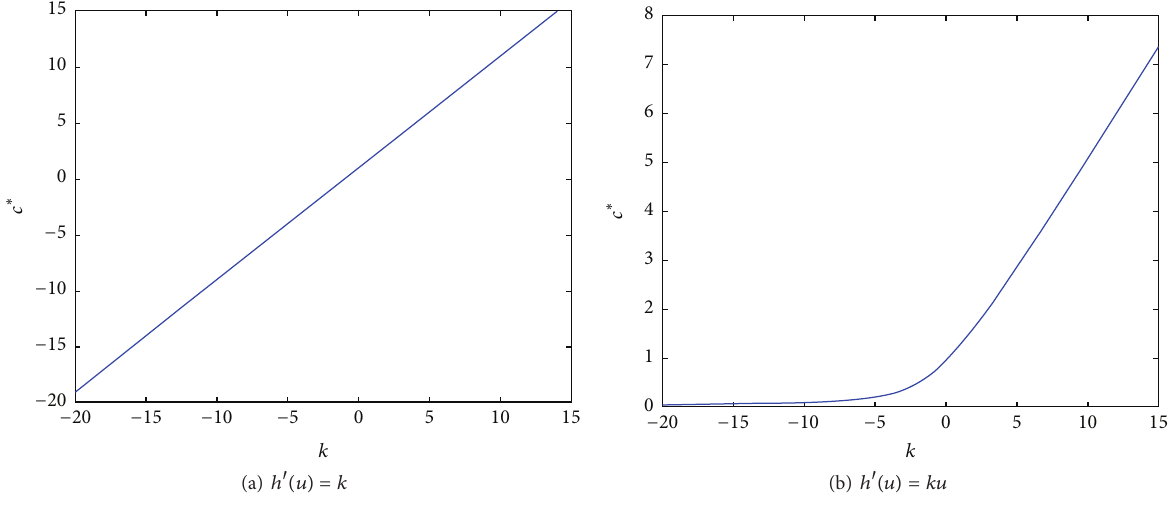
Figure 11: Plot 𝑐 ∗ as function of the parameter 𝑘 : for ℎ 󸀠 (𝑢) = 𝑘 and ℎ 󸀠 (𝑢) = 𝑘𝑢